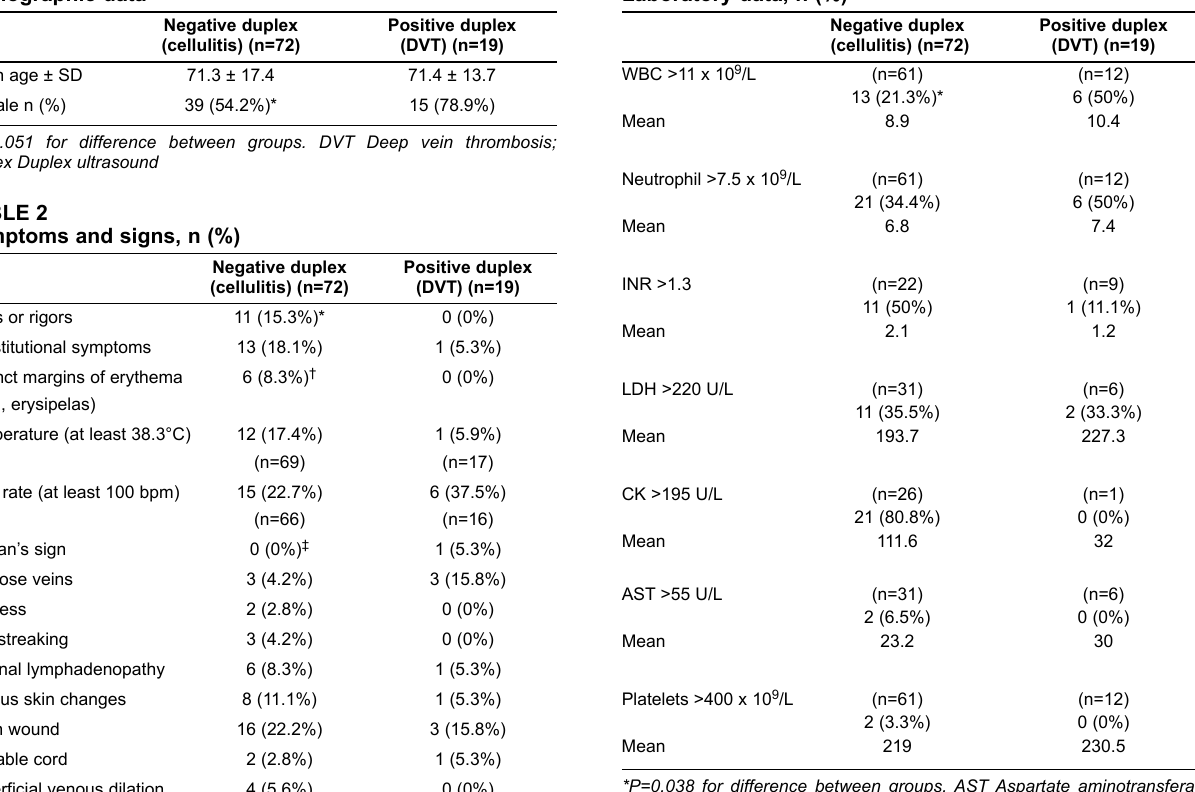
TABLE 3 Laboratory data, n